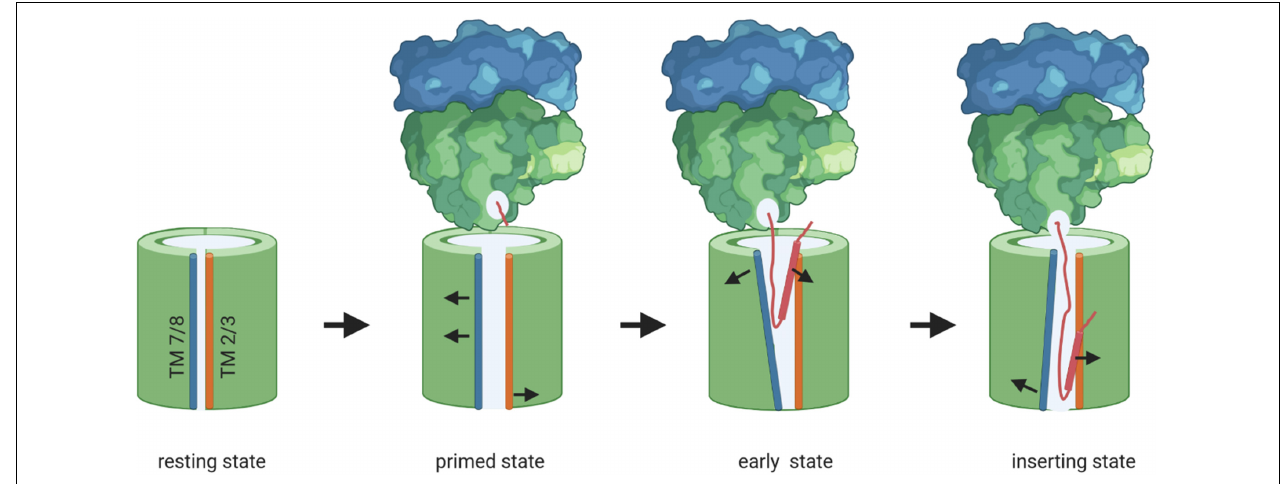
FIGURE 8 | Model of membrane protein insertion via the SecYEG translocon. In the resting state of the SecYEG-translocon, the lateral gate, composed of transmembrane domains (TMs) 2/3 on one side (orange) and TMs 7/8 (blue) on the other side, is closed. Binding of the translating ribosome to the cytosolically exposed loop connecting TM 6 and 7 of SecY (C5-loop, not shown), causes the lateral gate to slightly open, which is then primed for the approaching nascent chain. The emerging nascent membrane protein (red) disrupts contacts between TM 2 and TM 7 on the cytosolic side of the membrane further, while TM 7 moves closer toward TM 3 on the periplasmic side. This creates a V-shaped crevice during the early state of insertion. This state is likely further stabilized by the two N-terminal TMs of SecE (not shown). Ongoing chain elongation positions the hydrophobic core of the signal peptide (red zylinder) at the lateral gate, where it occupies approx. the same position as TM 2 in the resting SecYEG channel, before it is released into the